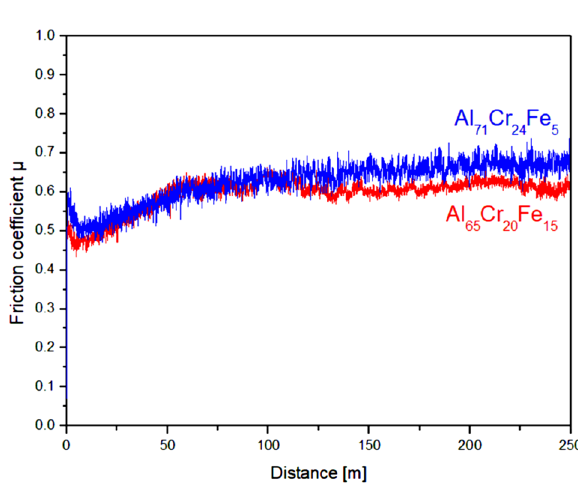
Figure 6. Pin-on-disc curves of Al 65 Cr 20 Fe 15 and Al 71 Cr 24 Fe 5 (ingots) as the relation of friction coefficient in the function of sliding